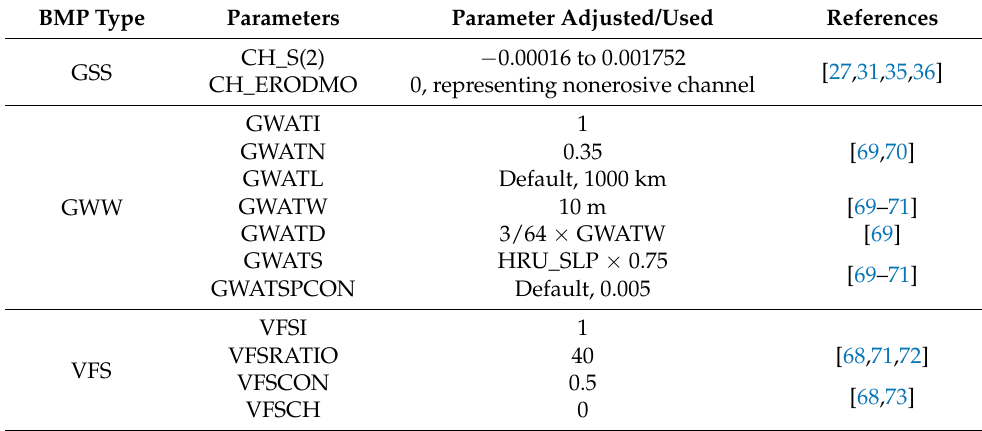
Table 3. Simulation of BMPs in